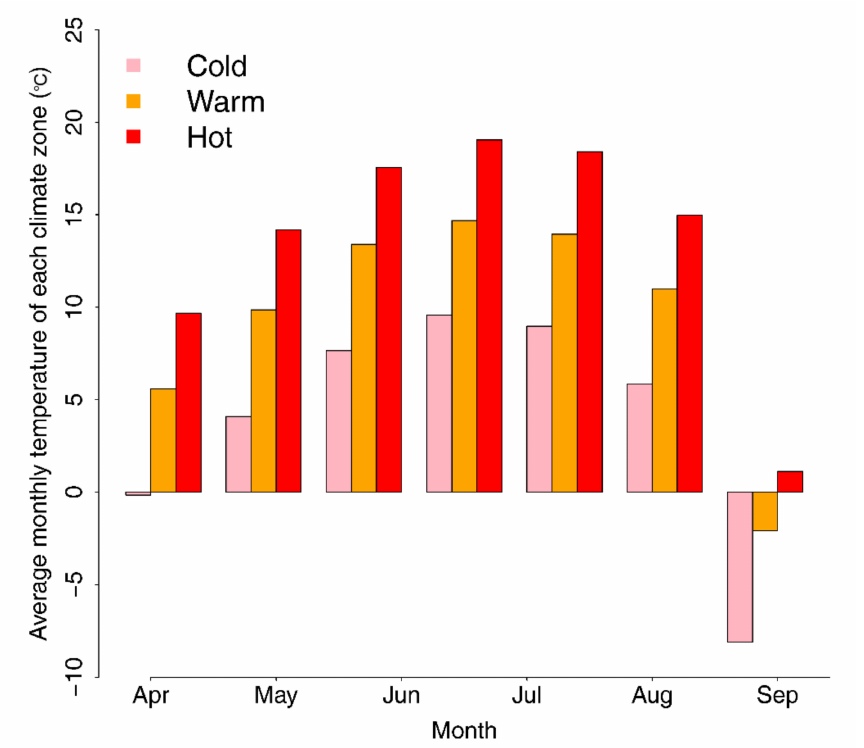
Figure A2. Mean monthly temperature of each month in (May to September) and around (April and October) the growing season during the year from 1960 to 2015 for climatic zones based on the zoning of